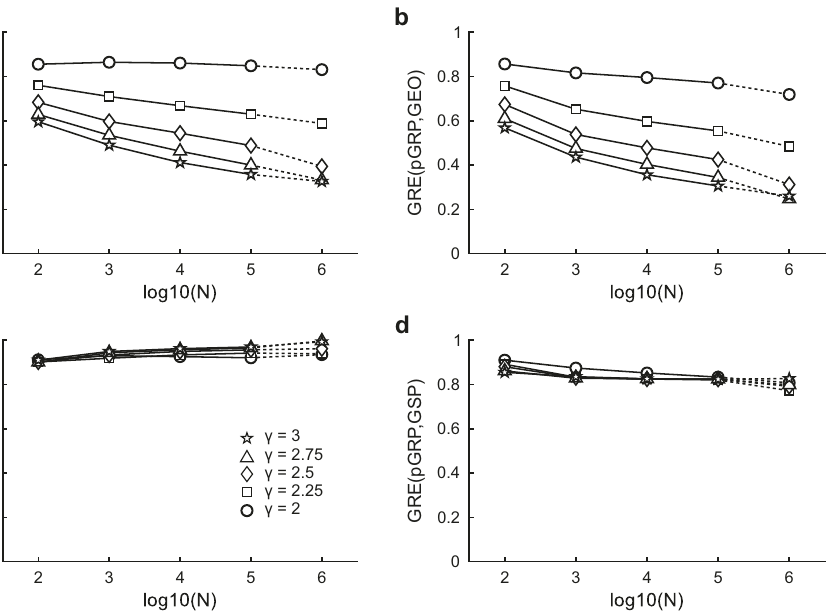
Fig.4|GCandGREevaluationforincreasingnetworksize. nPSO networks have been generated with parameters N = [100, 1000, 10000, 100000], (cid:1) d = 12, T = 0.1, γ = [2, 2.25, 2.5, 2.75, 3] and C = 4. For each combination of parameters, 10 networks have been generated. For each network we have computed: ( a ) GC(pTSP, GEO), ( b ) GRE(pGRP, GEO), ( c ) GC(pTSP, GSP), ( d ) GRE(pGRP, GSP). Each plot reports 5 curves for the different values of γ , indicating the mean value